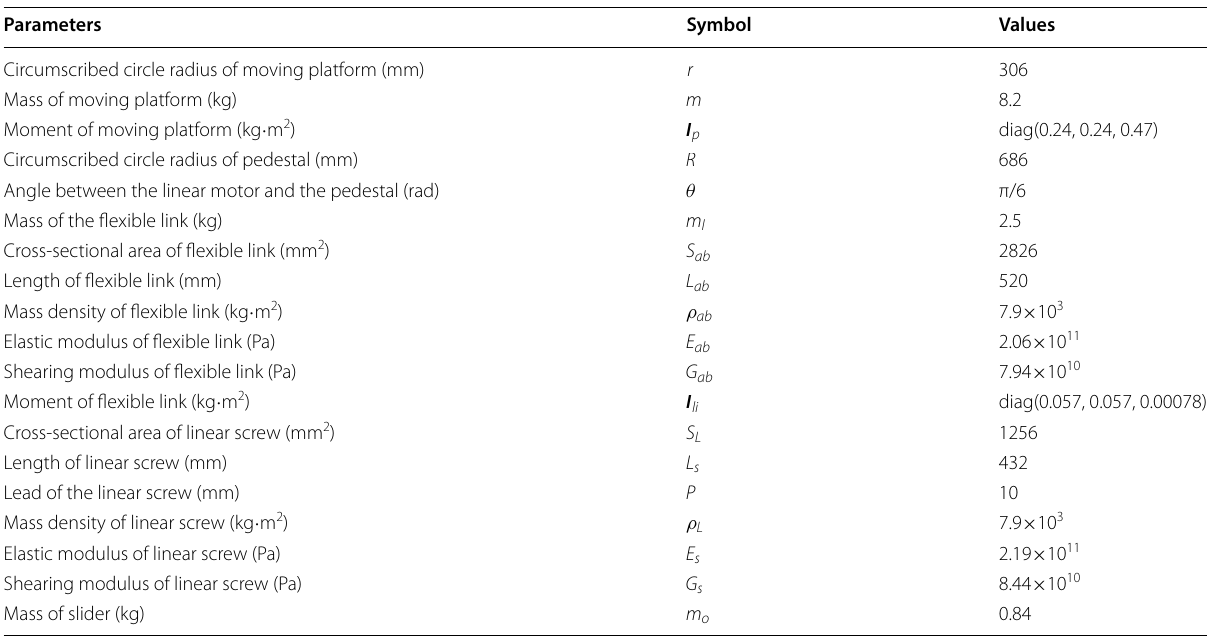
Table 1 Parameters of the 5-PSS/UPU parallel mechanism Parameters Symbol Values Circumscribed circle radius of moving platform